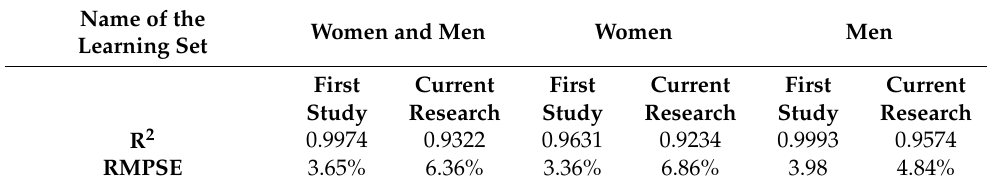
Table 11. Comparison of the quality of the models from the first phase of the study and the cur- rent ones. Name of the Learning Set